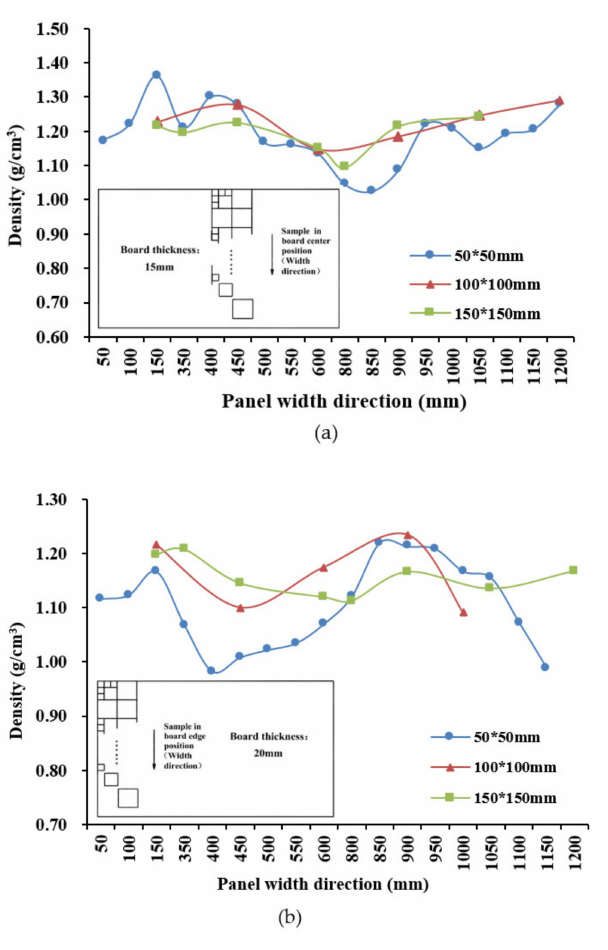
Figure 9. Density distribution across panel width for ( a ) centerline and ( b ) end of panel.